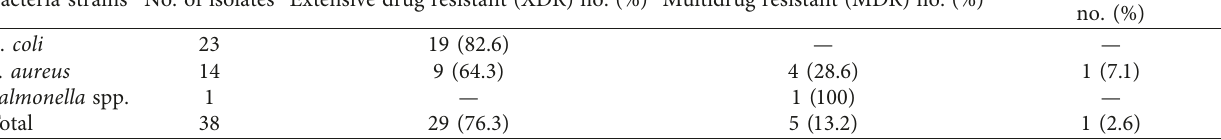
Table 8: Drug resistance pattern of isolated